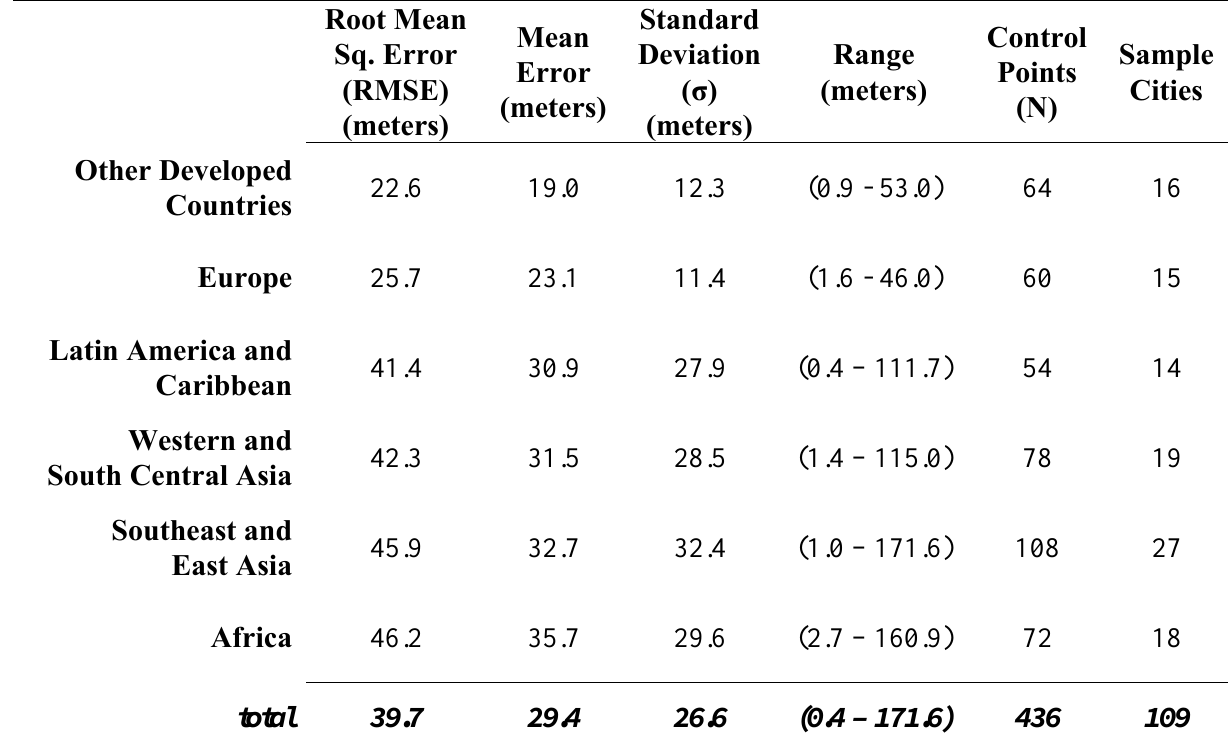
Table 1. Error vector magnitudes by world region, and globally. ‘Other developed countries’ refers to the United States, Canada, Australia, New Zealand, and